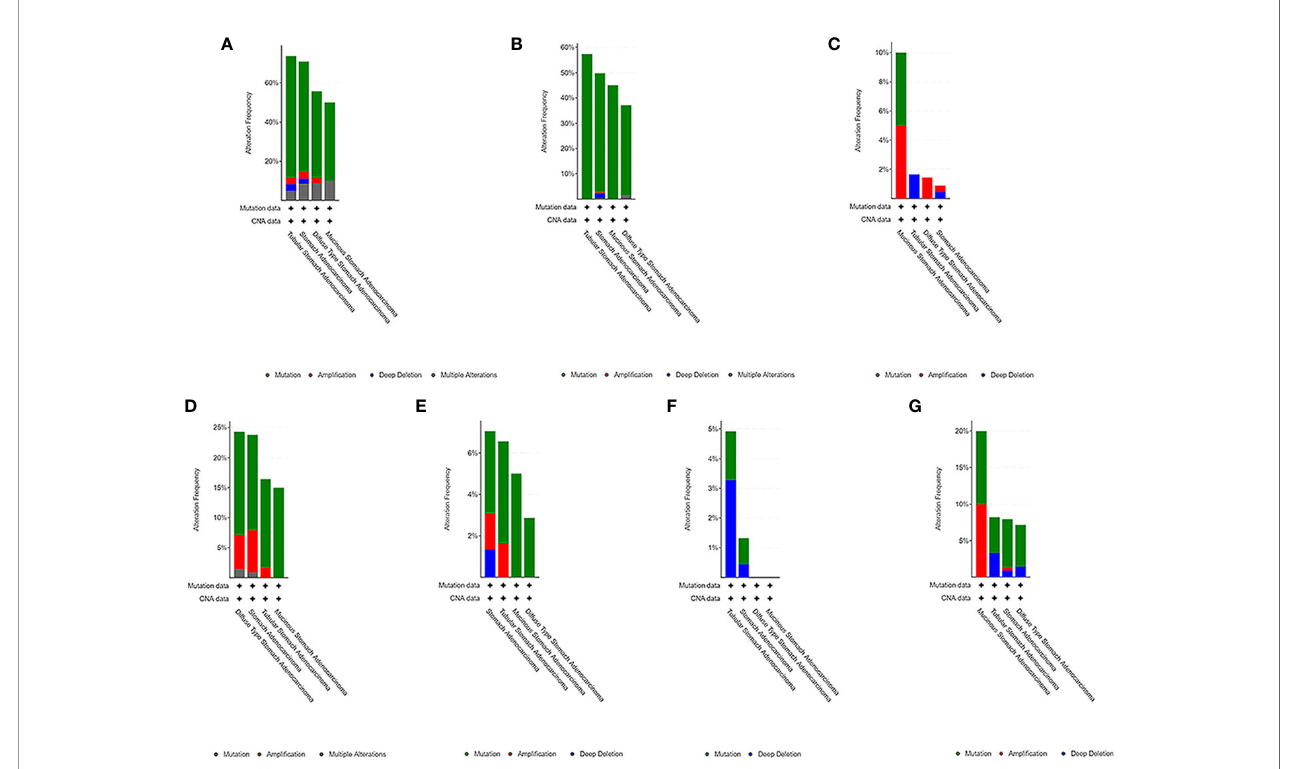
FIGURE 9 | Genome-speci fi c changes in the pivotal genes in 5 gastric cancer data sets. (A) All hub genes; (B) TP53; (C) HRAS; (D) BRCA1; (E) PIK3CA; (F) AKT1; (G) SMARCA4. Each row represents a gene, and each column represents a tumor sample. Red bars, gene ampli fi cations. Blue bars, deletions. Green squares, missense mutations.